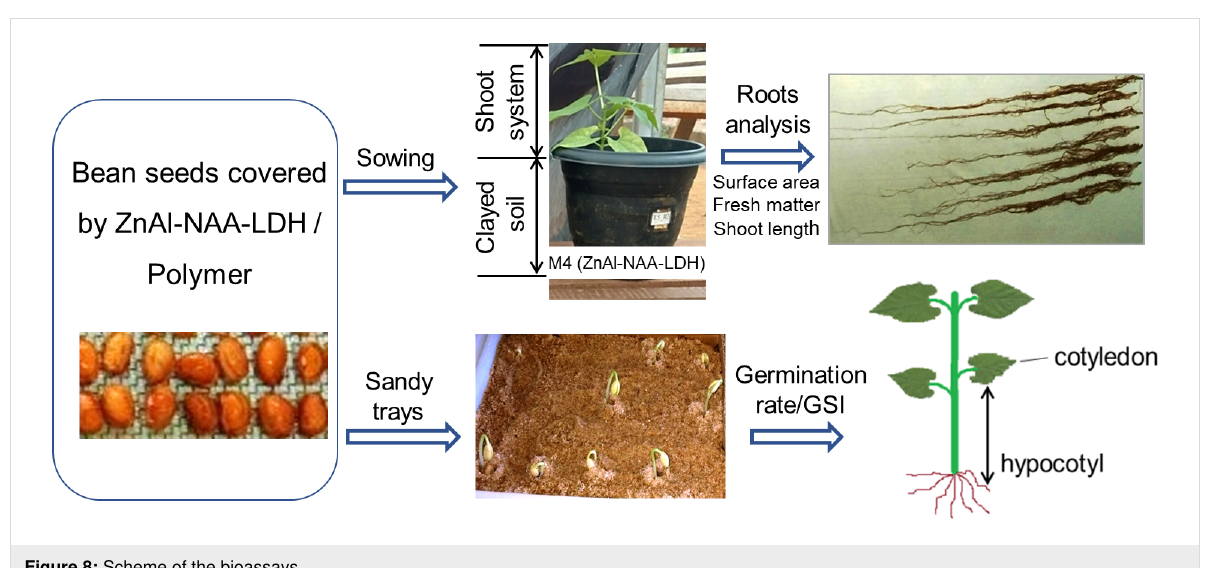
Figure 8: Scheme of the bioassays.